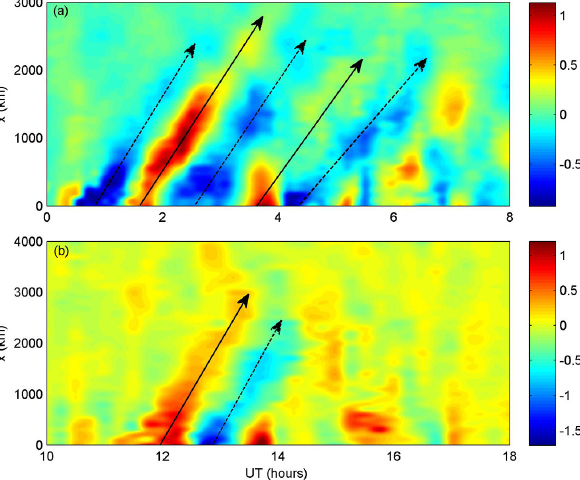
Fig. 5. TEC variation as a function of horizontal distance and uni- versal time (UT) during the periods when the LSTIDs occurred on the morning of 30 May (panel a ) and the evening of 1 June (panel b ). The horizontal distance is calculated along the one-dimensional axis, x , perpendicular to the wavefronts and directed toward an az- imuth of 21 ◦ for the morning LSTID on 30 May and toward 333 ◦ for the nighttime event on 1 June. The origins of the axis were set at (20 ◦ N, 98 ◦ E) for the morning event and (20 ◦ N, 105 ◦ E) for the nighttime event, the positions where the band-like structures that are associated with the LSTIDs first appeared. The black lines mark the phase fronts in the x–UT plane.